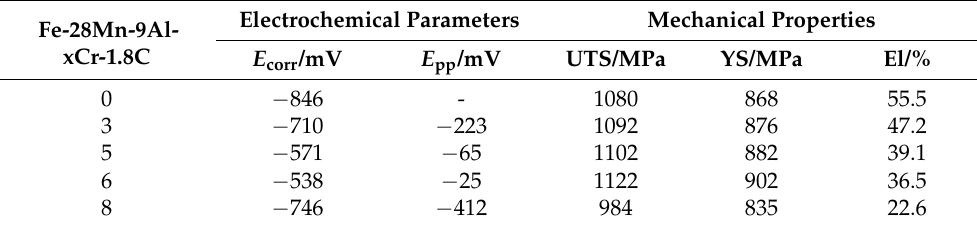
Table 2. Electrochemical parameters and mechanical properties of Fe-28Mn-9Al-xCr-1.8C, data from [38]. Electrochemical Parameters Mechanical Fe-28Mn-9Al- xCr-1.8C